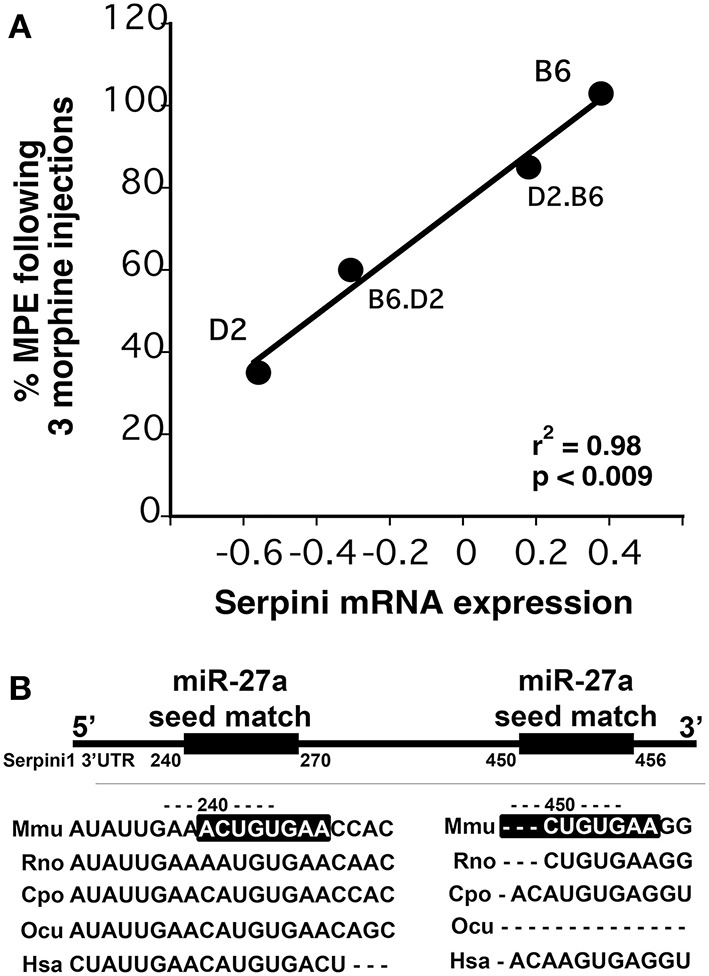
(A) Correlation between Dicer1 mRNA expression and tolerance (as measured by a decrease in the maximal possible effect; %MPE) following 3 morphine administrations in 4 genotypes (data derived from (Tapocik et al., 2009)). (B) Map of the putative binding sites of miR-27a on the 3′UTR of Serpini1 and mirSVR scores (derived from microRNA.org). The combined mirSVR score = −1.9421. Mmu, Mus musculus; Rno, Rattus norvegicus; Cpo, Cavia porcellus; Ocu, Oryctolagus cuniculus; Hsa, Homo sapiens.